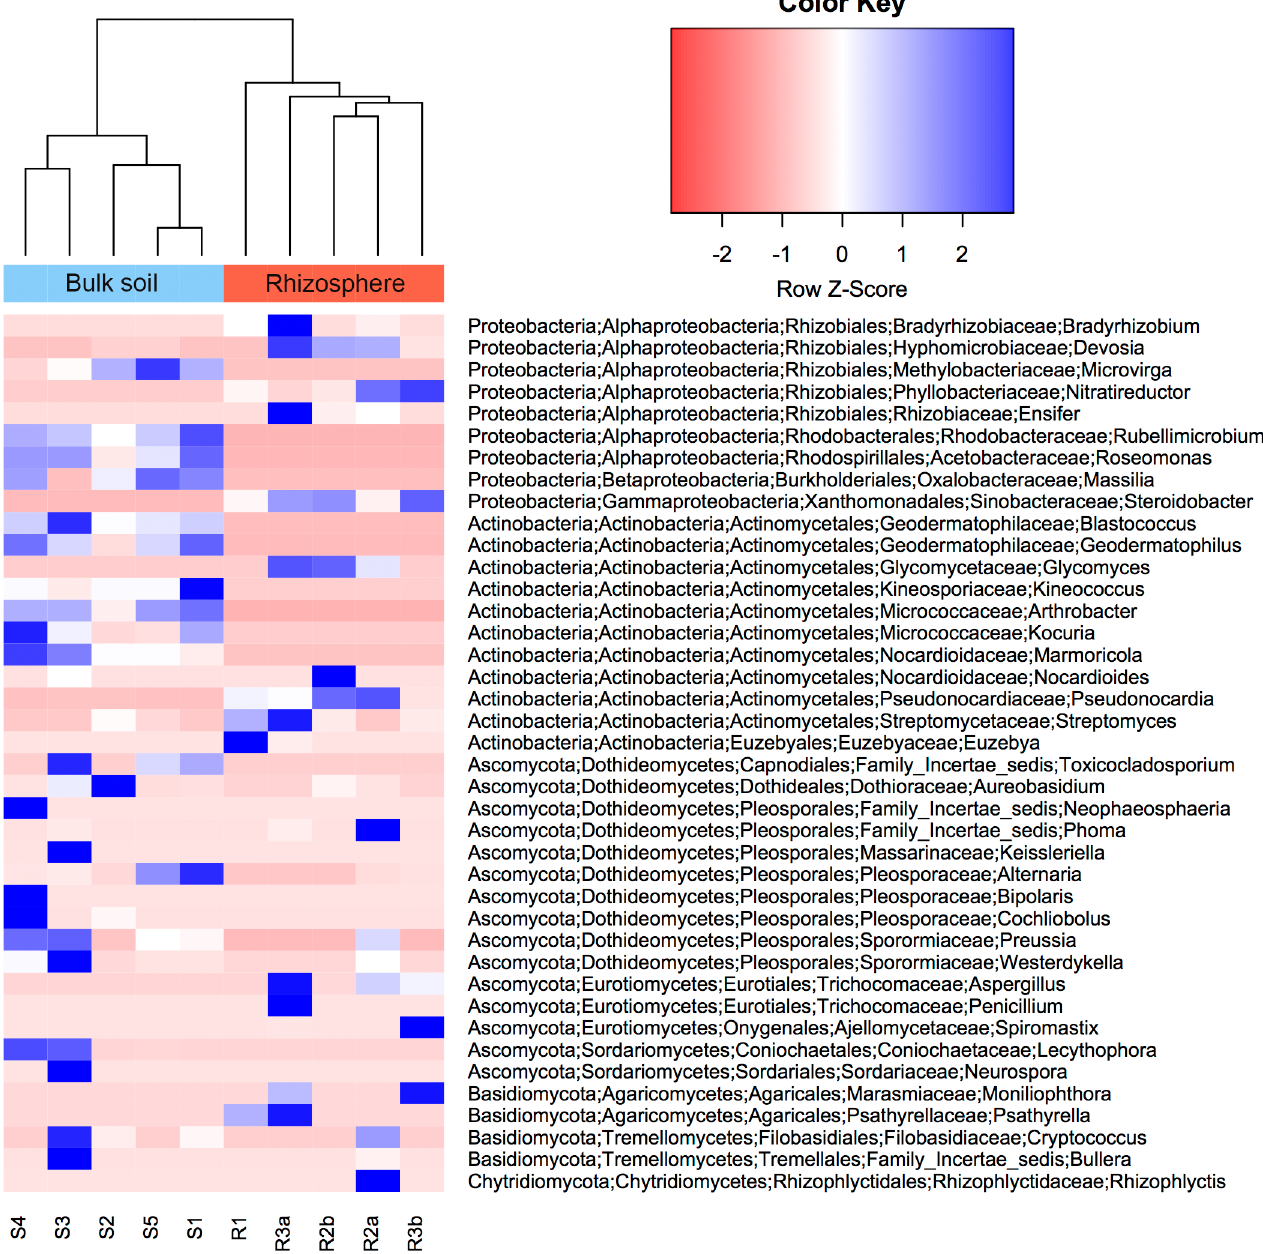
Fig 2. Heatmap displaying the most abundant genera for rhizosphere and bulk soil samples. Samples are clustered based on the percent relative abundance of the forty dominant genera (twenty bacteria and twenty fungal genera) shown as rows in this figure. Taxonomy for each genus is presented in the order: phylum, class, order, family, genus. Sample nomenclature indicates the sample type (S = bulk soil; R = rhizosphere), replicate (S = 1 to 5, R = 1 to 3) and pseudoreplicate (a, b).